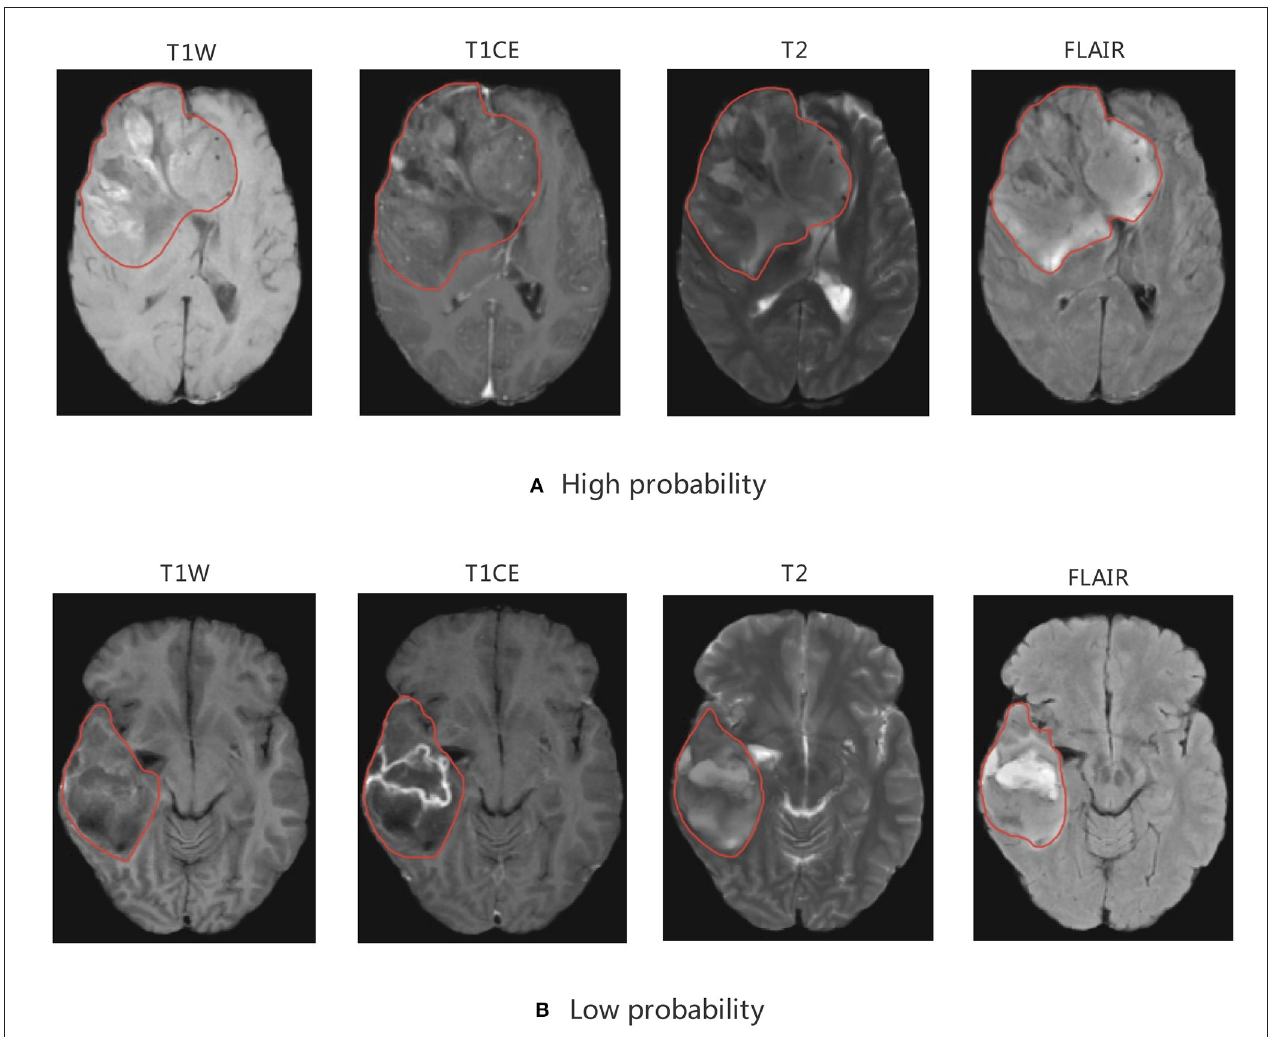
FIGURE 10 | MRI of model-based CIC mutation prediction patients. Image with the (A) high probability of being CIC mutation and (B) low probability of being CIC mutation. The region inside the red line represents glioma